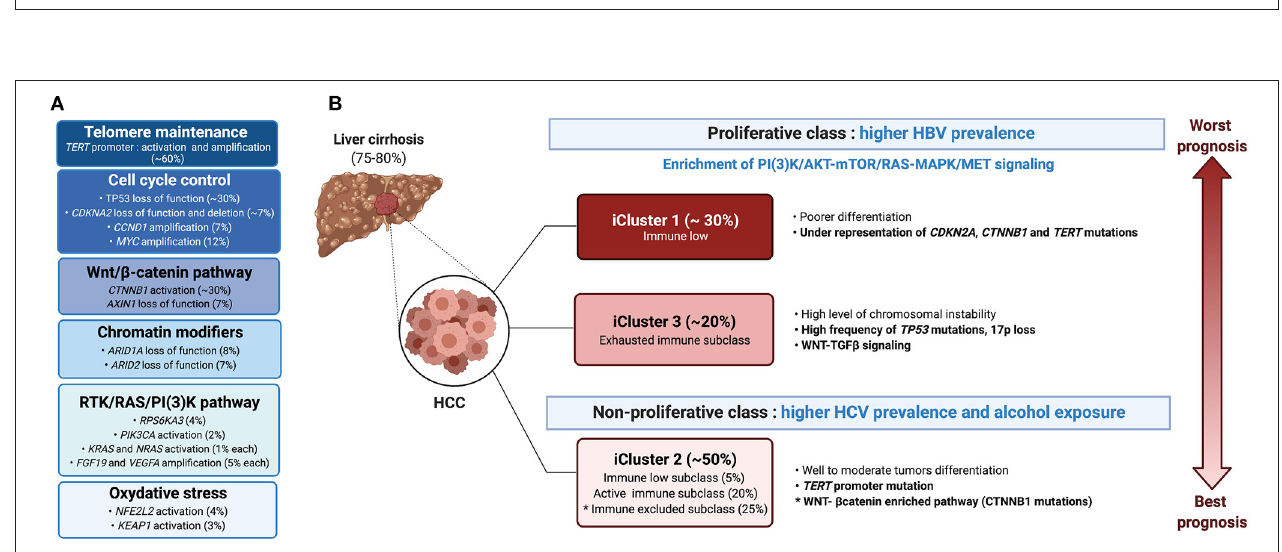
FIGURE 3 | the normal liver, with green arrows indicating an expansion, red arrows a depletion and blue horizontal arrow no change in the examined cell subset. The cellular landscapes of the healthy and cirrhotic livers were from (26). The information on the HCC landscape was from (27), but with complementary information from the following studies: γδ T cells and M2 macrophages (28), cancer-associated fibroblasts (CAFs) and tumor-endothelial cells (TECs) (29). New subsets of cells arising in the cirrhotic condition are also depicted and labeled as ‘scar-associated’ cells: SAEndo: scar-associated endothelial cells; SAMes: scar-associated mesenchymal